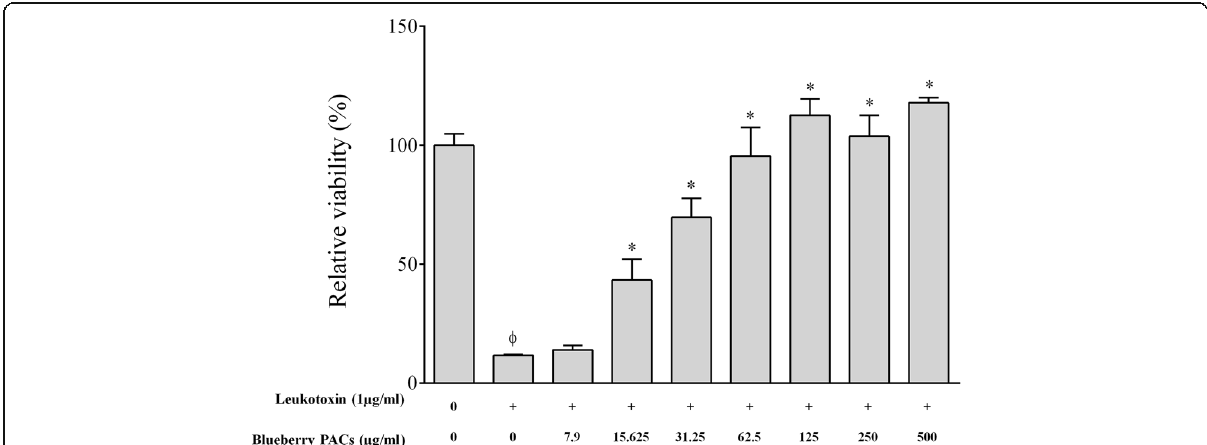
Fig. 5 Effect of highbush blueberry PACs on A. actinomycetemcomitans leukotoxin (LtxA) activity on macrophage-like cells. Φ : significant loss of cell viability ( p <0.001) compared to control cells not treated with LtxA. *: significant increase of cell viability ( p <0.001) compared to cells treated with